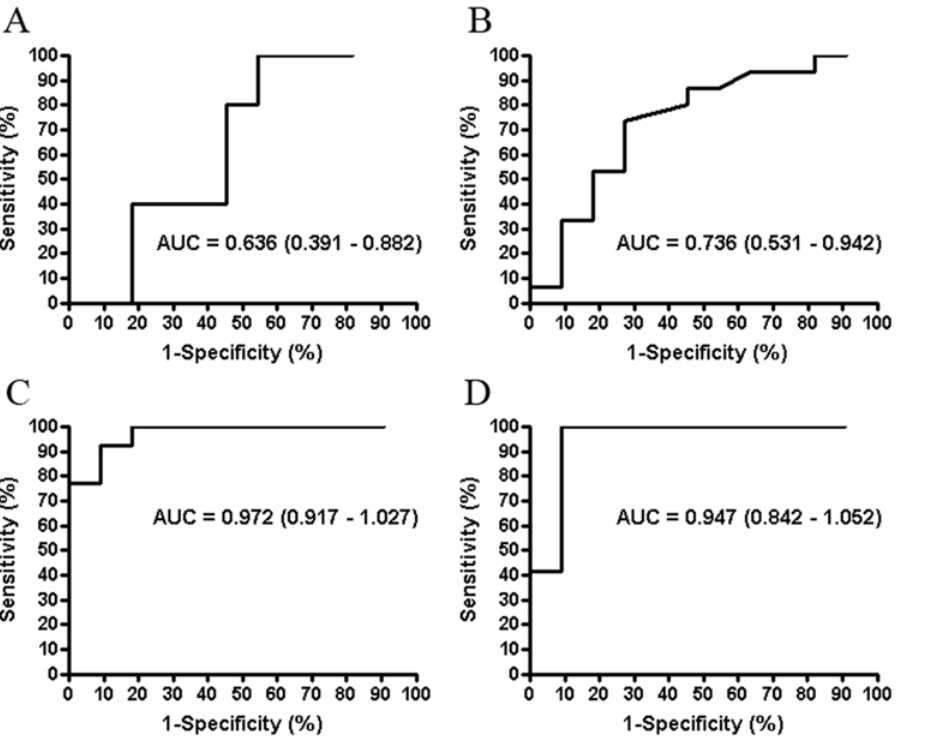
Figure 4. ROC curves were constructed to compare ELISPOT results when the cells were stimulated with rMtb-HBHA (A), PPD (B), and peptide mixtures of ESAT-6 and CFP-10 (C–D). The curves were established for infected (Active and Inactive TB) and the healthy control group. The calculated AUC and the respective confidence intervals (in brackets) are shown for each tested antigen.